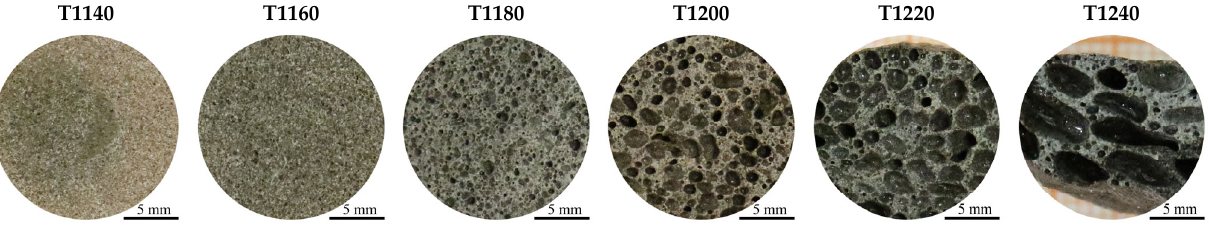
Figure 4. Cross-sectional images of samples sintered at different temperatures for 20 min.